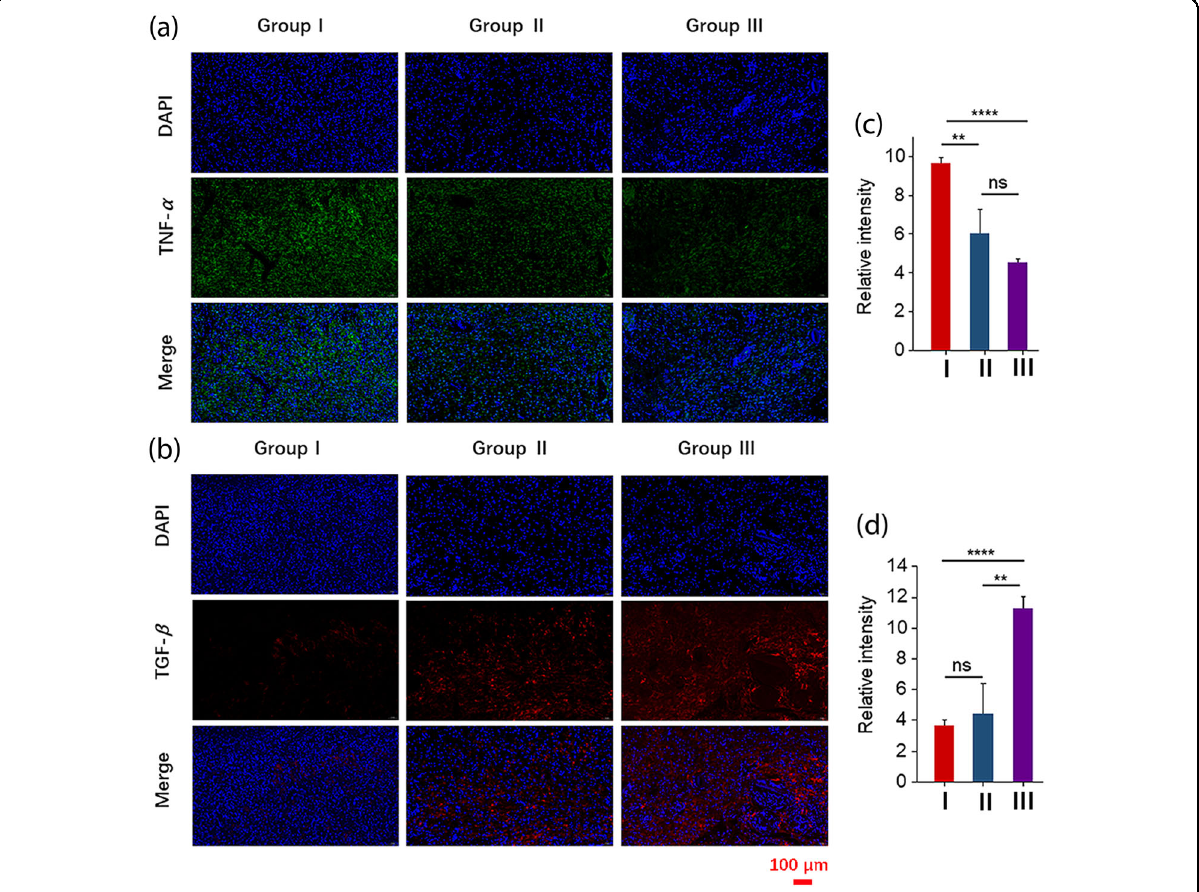
Fig. 5 Immuno fl uorescence analysis of wound healing process. Representative images of ( a ) M1 macrophage (TNF- α ) and ( b ) M2 macrophage (TGF- β ) immuno fl uorescence staining on Day 14 and statistical data of the relative intensity of ( c ) TNF- α and ( d ) TGF- β ( n = 4) (** P < 0.01, **** P < 0.0001, ns: no signi fi cant